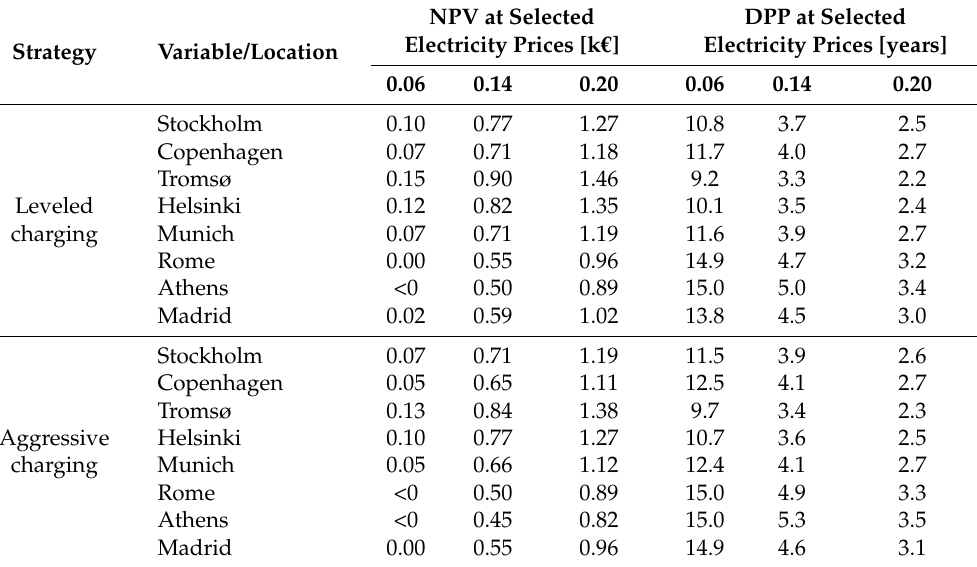
Table 8. Net present value (NPV) and discounted payback period (DPP) for selected cities with the EJ design at different electricity prices when applying the leveled and aggressive charging